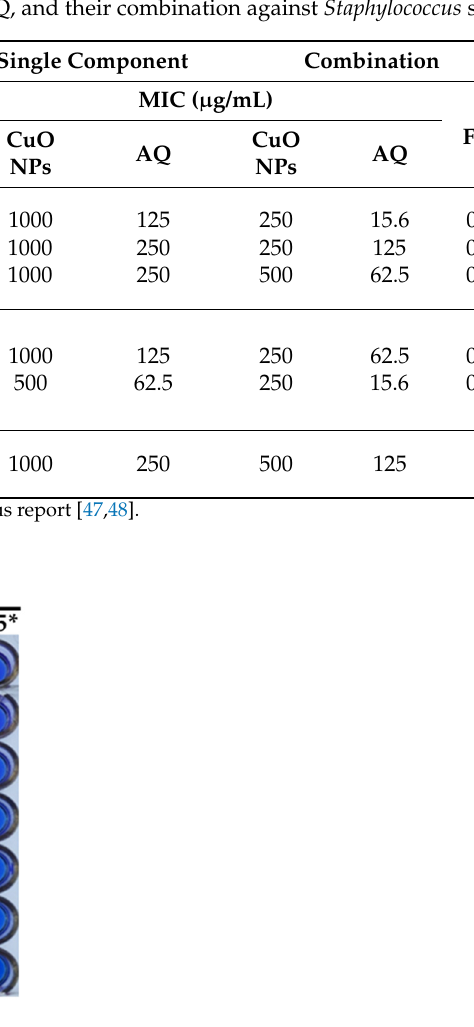
Table 1. MIC of CuO NPs and AQ against Staphylococcus strains.